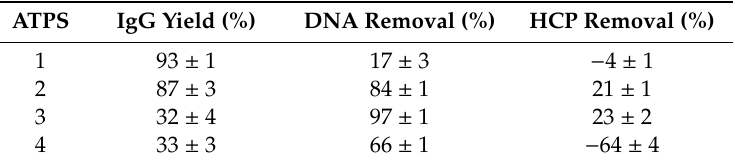
Table 2. IgG yield and removal of process related impurities of the investigated model ATPS in the LP. Cell containing cultivation broth was used as the feed component. IgG: immunoglobulin type G. ATPS: aqueous two-phase system. LP: light phase. ATPS IgG Yield (%) DNA Removal